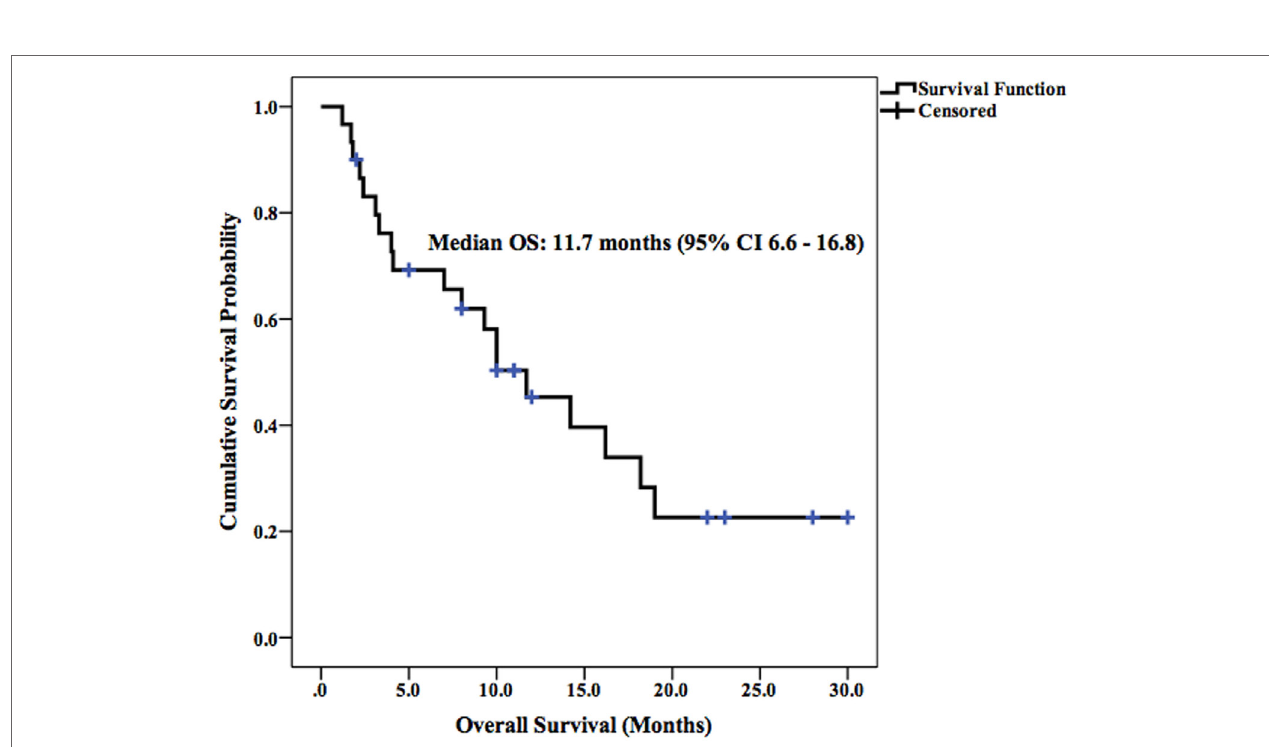
FigUre 3 | Kaplan–Meier curve of Os in patients receiving sirT